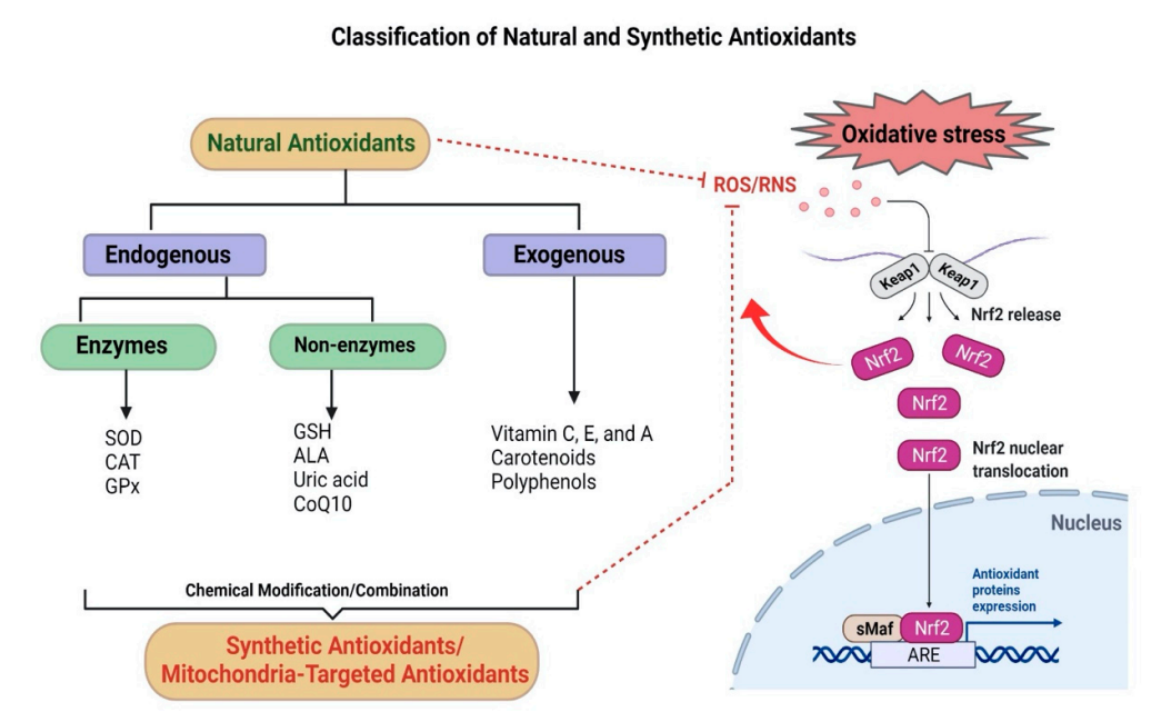
Figure 4. Natural and synthetic antioxidants: Classification of natural and synthetic antioxidants and the endogenous Nrf2 pathway, which regulates the activation of ARE genes. Kelch-like ECH- associated protein 1 (Keap1) represents a negative regulator of Nrf2. Under physiological conditions, Keap1 forms a ubiquitin E3 ligase complex with Cullin3 in the cytoplasm that targets Nrf2 for polyubiquitination and rapid proteasomal degradation. During oxidative stress, cysteines in Keap1 are modified and inactivated, and Nrf2 can quickly translocate into the nucleus, where it binds to small musculoaponeurotic fibrosarcoma oncogene homolog (sMaf) proteins, upregulates downstream ARE genes, and maintains redox